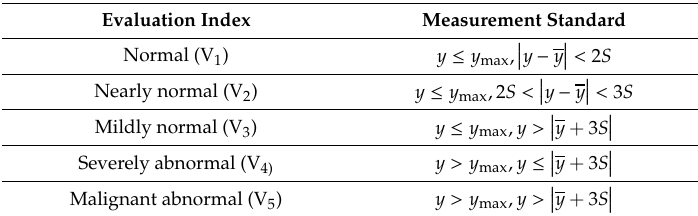
n (cid:80) − y ( y ) 2 / n i i i = 1